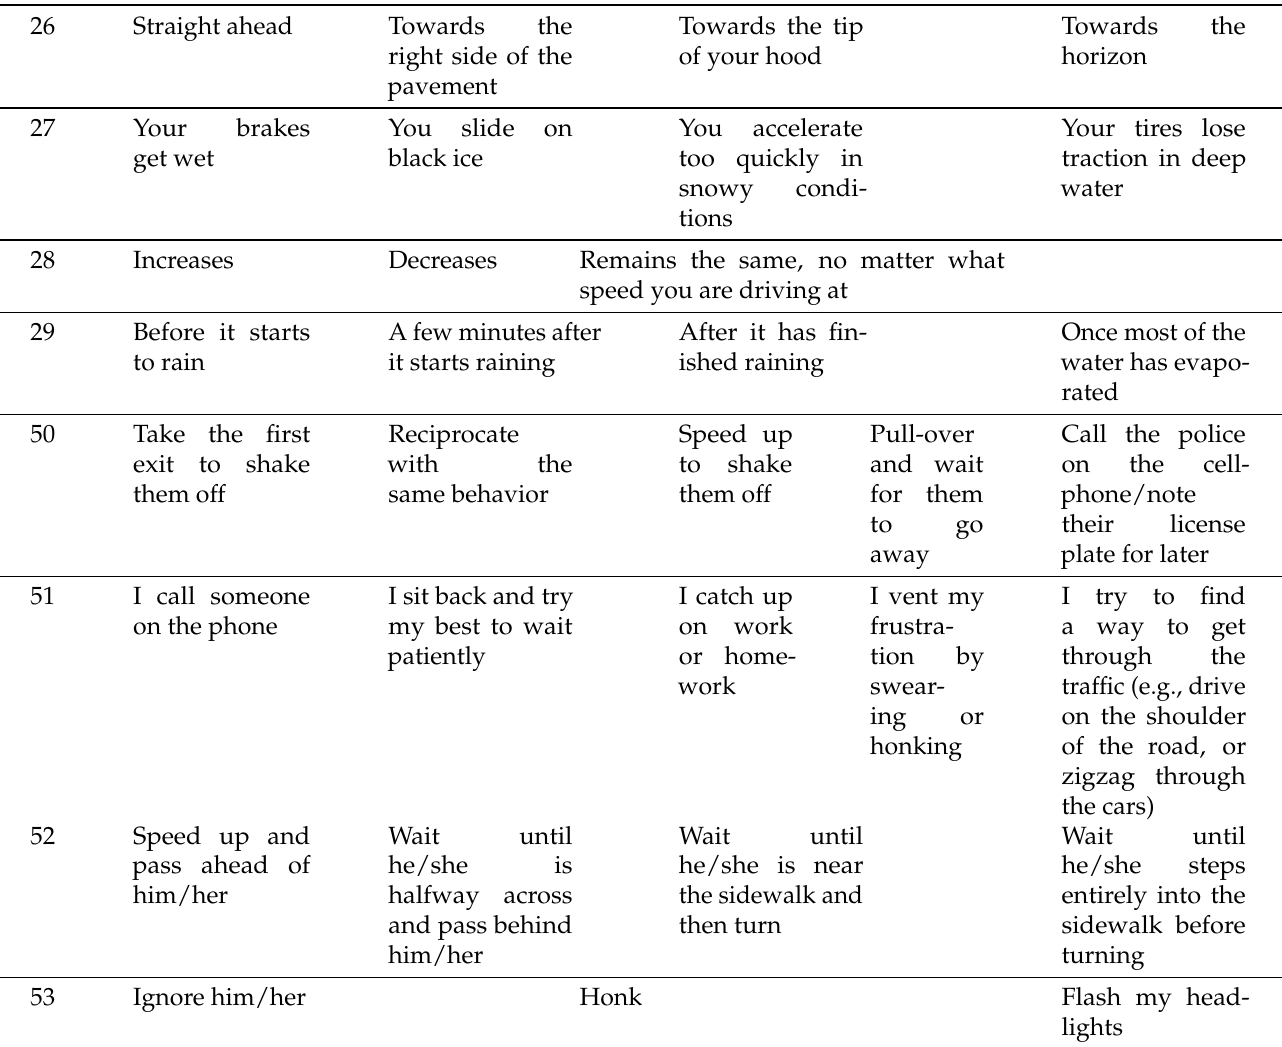
Table 2. Multiple option